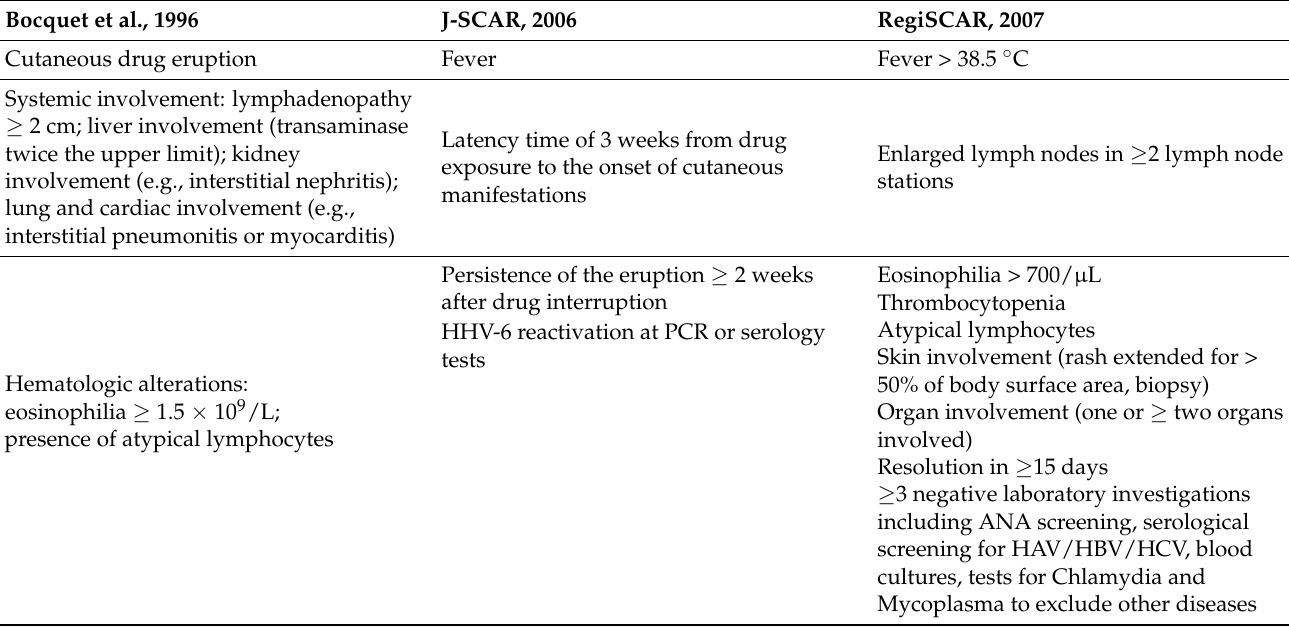
Table 4. Comparison between three scoring